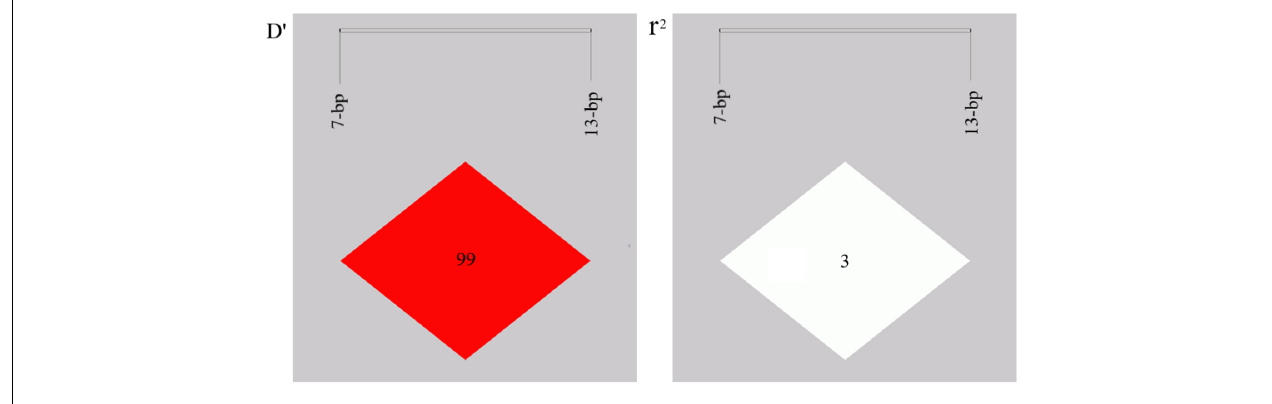
FIGURE 2 | Linkage disequilibrium plot of the AKAP12 gene two indel loci. TABLE 3 | Associations of two indel loci with first-born litter size in Shaanbei white cashmere (SBWC) goats. Loci Rs number Genotypes p